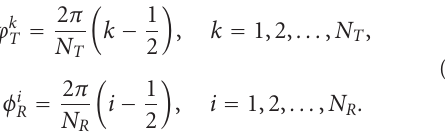
described in [22] in details. This method is extended in [11, 12, 14] for simulating the MIMO M-to-M DBTR reference model. According to MEDS method the discrete AODs ϕ k T and AOAs φ i R are determined by